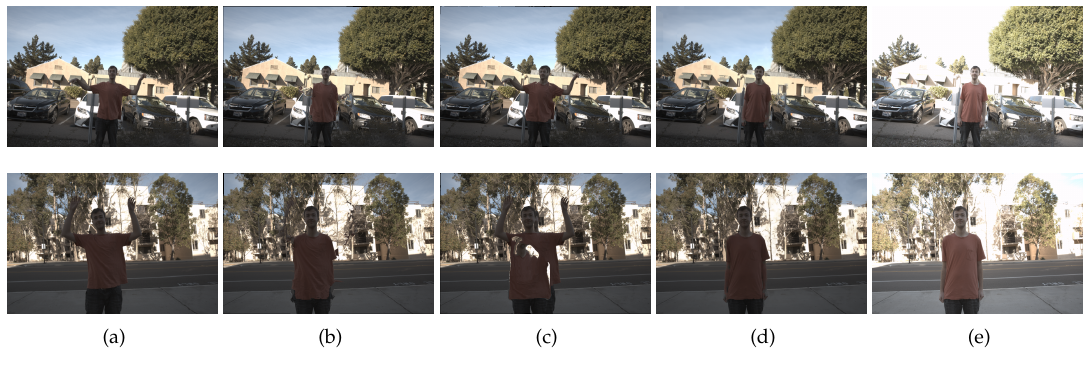
Figure 8. Visual comparisons of alignment methods. We conducted alignment using various alignment algorithms for warping ( a ) Non-reference LDR towards ( e ) Reference LDR I 2 . The warping results are presented in ( b ) SIFTflow, ( c ) PWC-Net, ( d ) our method.